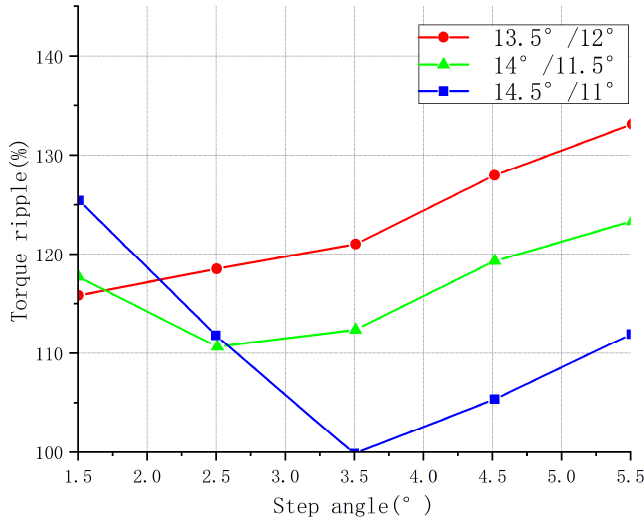
Figure 7. Torque fluctuation of different step angles for three parameter combinations.